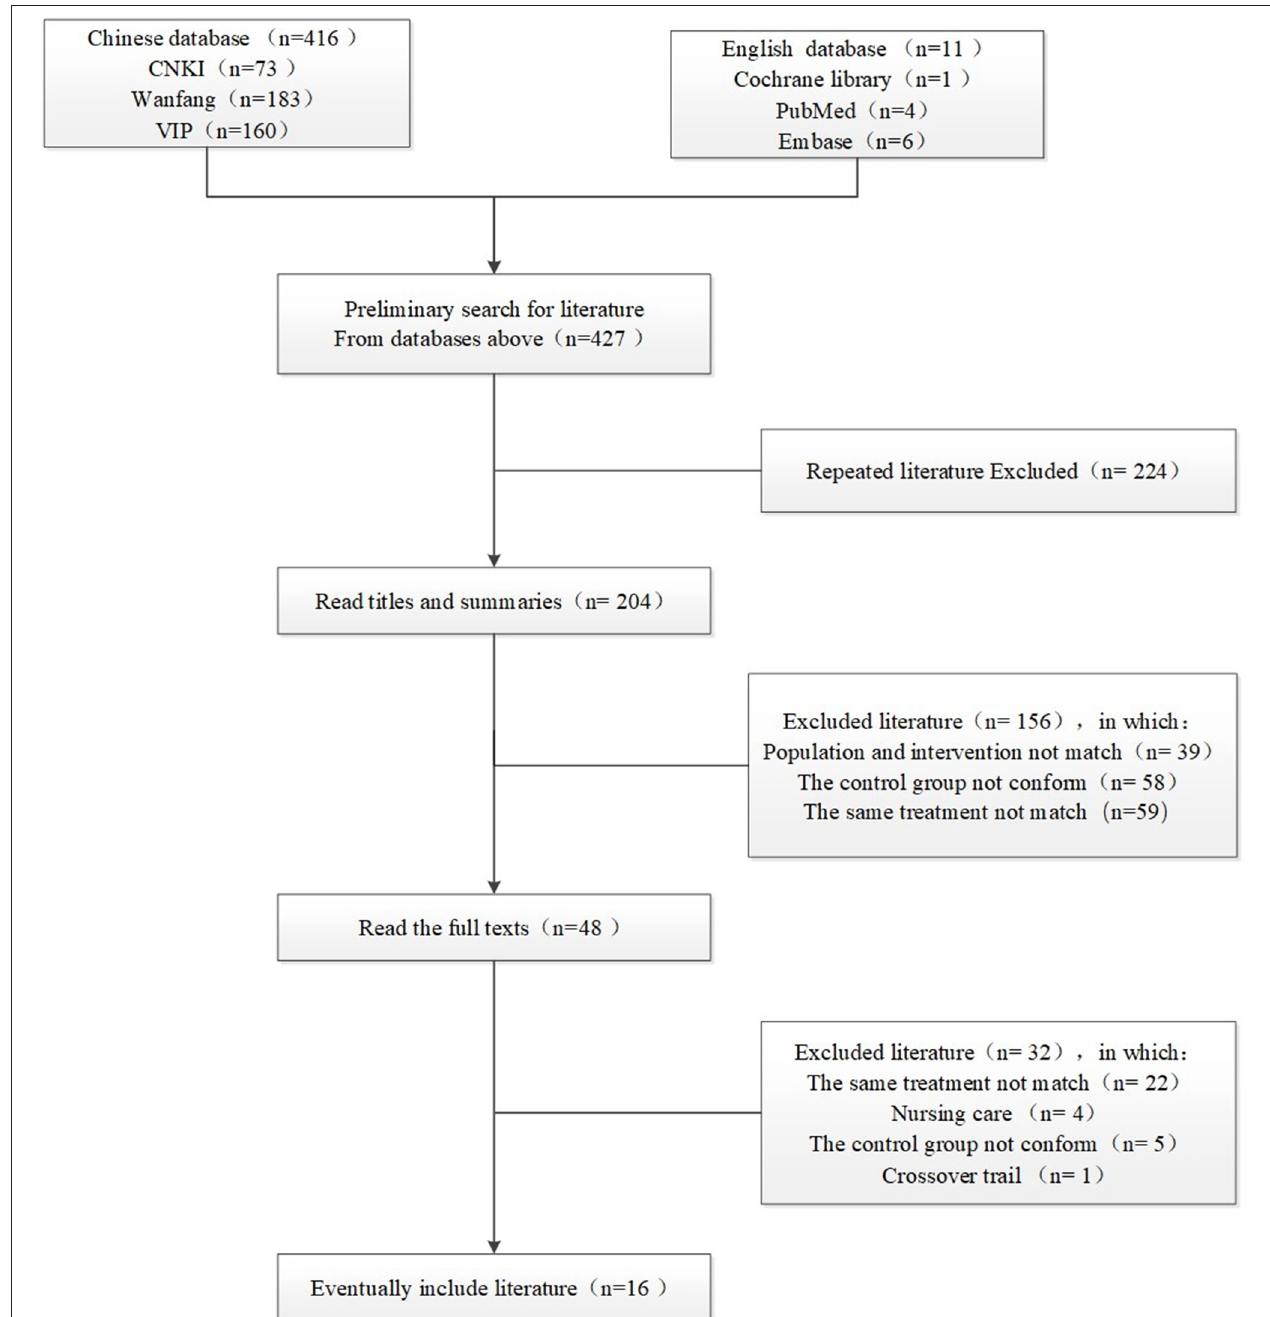
FIGURE 1 | Literature screening flow